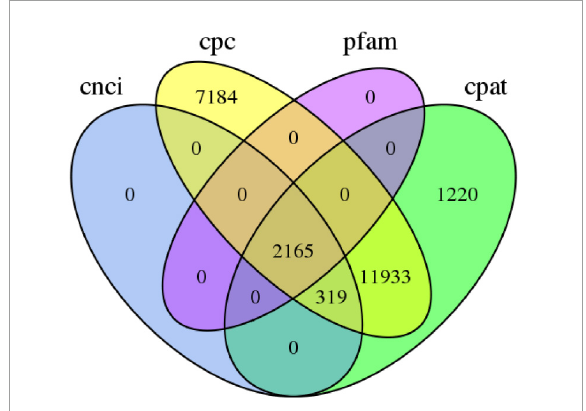
FIGURE4 The number of long noncoding RNA transcripts predicted according to the CPC, CNCI, CPAT, and Pfam